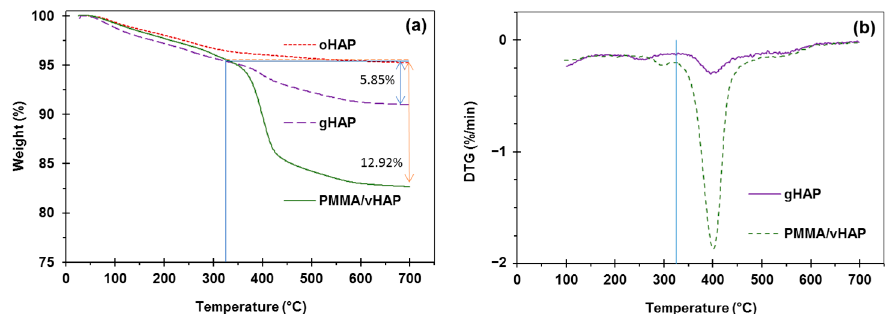
Figure 4. ( a ): TGA curves of PMMA/vHAP nanocomposite and gHAP (extracted from the nano- composite), ( b ): DTG curves of PMMA/vHAP nanocomposite and gHAP. (Note: TGA curve of oHAP is used for comparison).